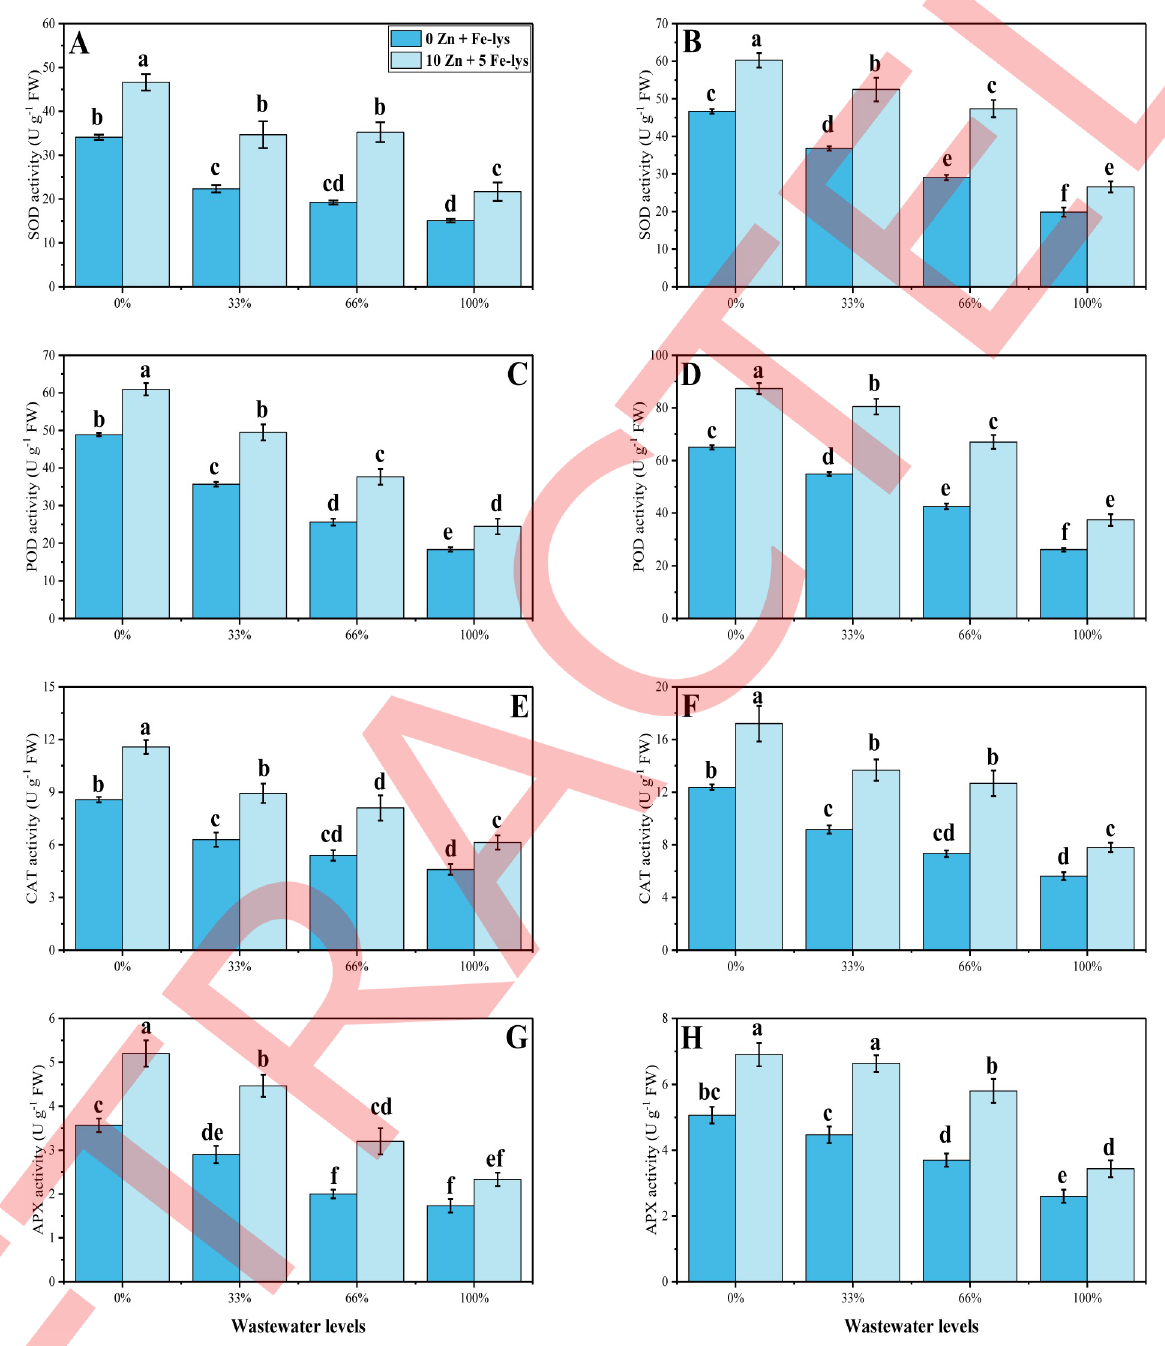
Fig 4. Effect different levels of tannery wastewater on SOD activity in the roots (A), SOD activity in the leaves (B), POD activity in the roots (C), POD activity in the leaves (D), CAT activity in the roots (E), CAT activity in the leaves (F), APX activity in the roots (G) and APX activity in the leaves (H) under the application of Zn and Fe-lys on B . napus . Values are demonstrated as means of three replicates along with standard deviation (SD; n = 3). One-way ANOVA was performed and means differences were tested by HSD ( P < 0.05). Different lowercase letters on the error bars indicate significant difference between the treatments. Different levels of tannery wastewater used are as follow: 0 (without irrigation with wastewater), 33 (33% irrigation with wastewater), 66 (66% irrigation with wastewater) and 100 (100% irrigation with